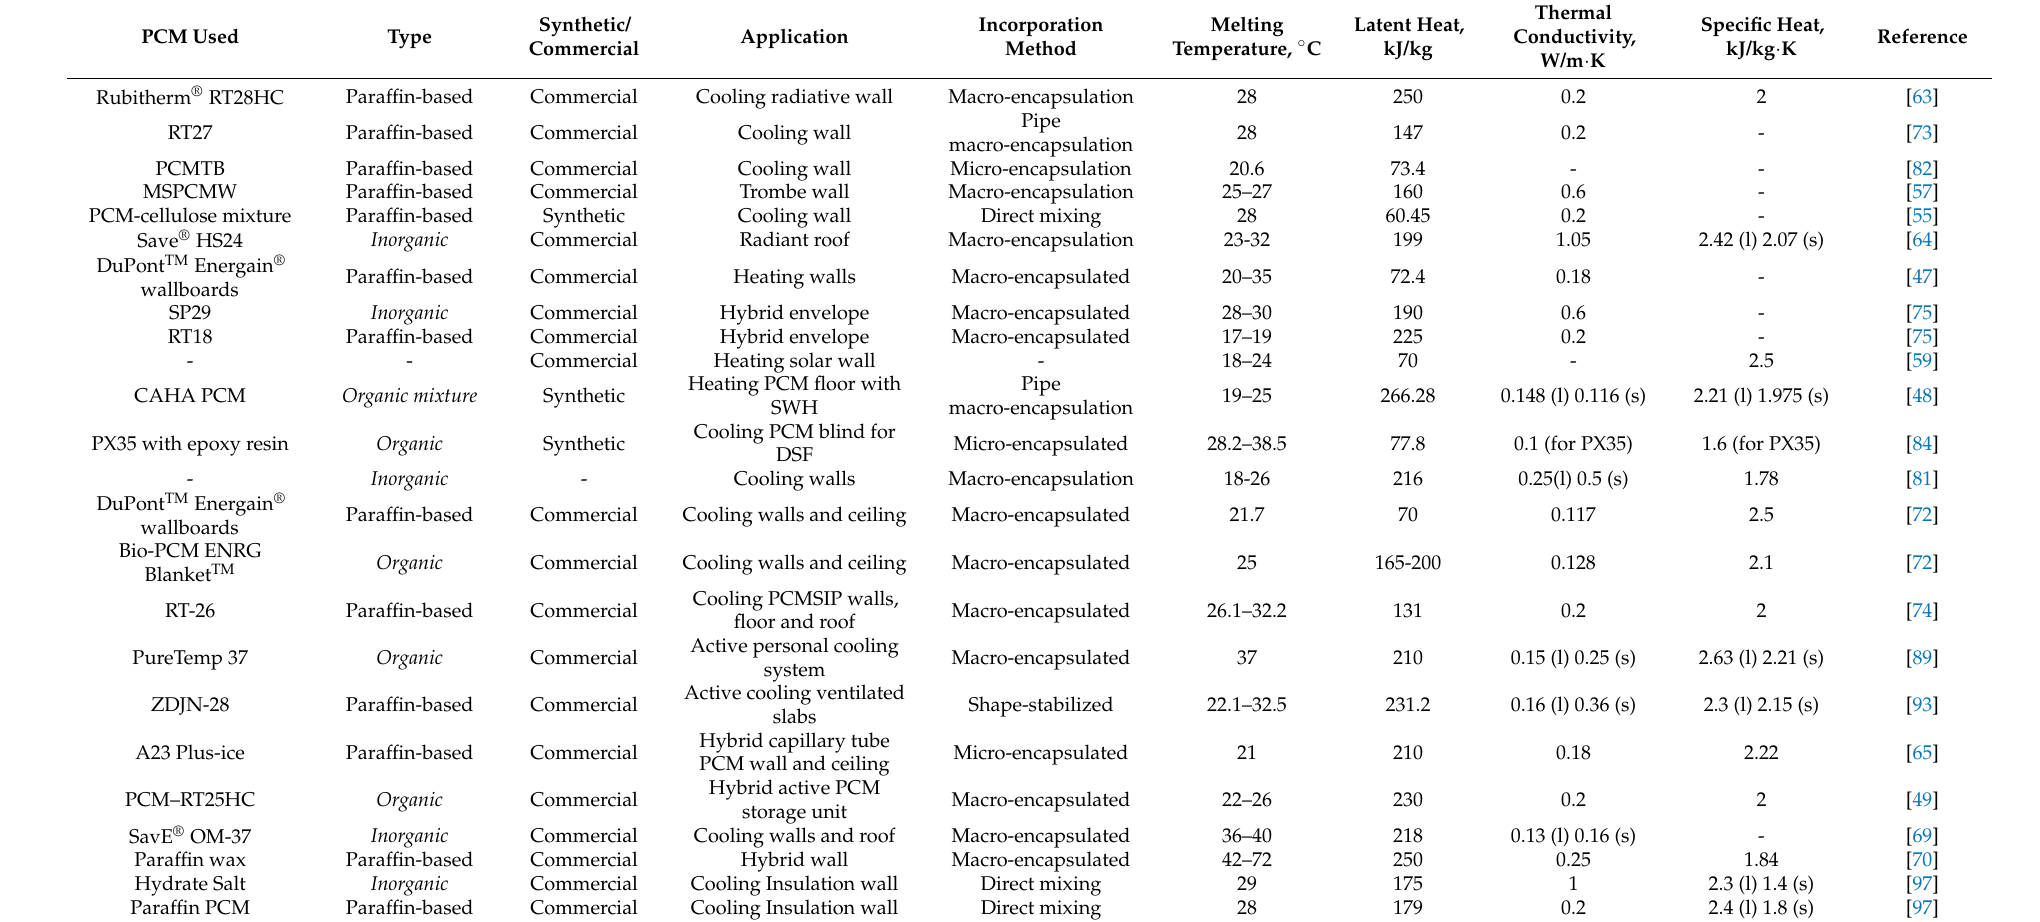
Table 2. Thermophysical properties of key PCMs used in experimental building